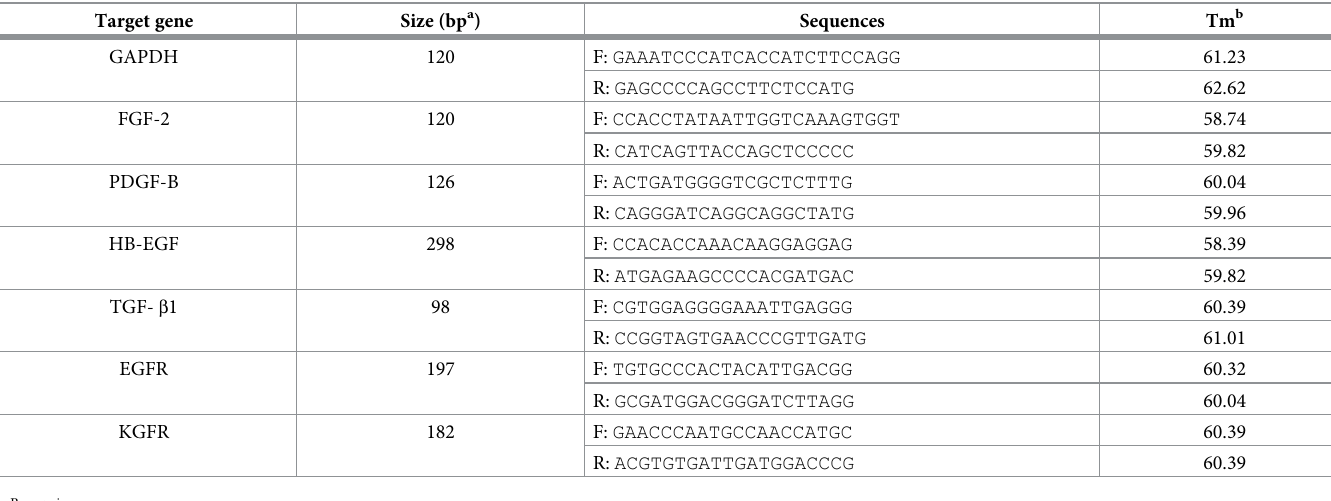
Table 1. Primer sequences of target genes. Target